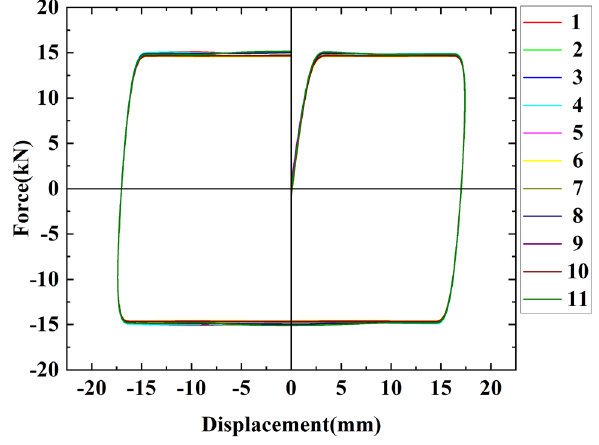
Figure 17. Area division of the angle steel of friction energy dissipation composite chord. Figure 18. Relationship between friction and displacement in each area of the angle steel of friction energy dissipation composite chord.